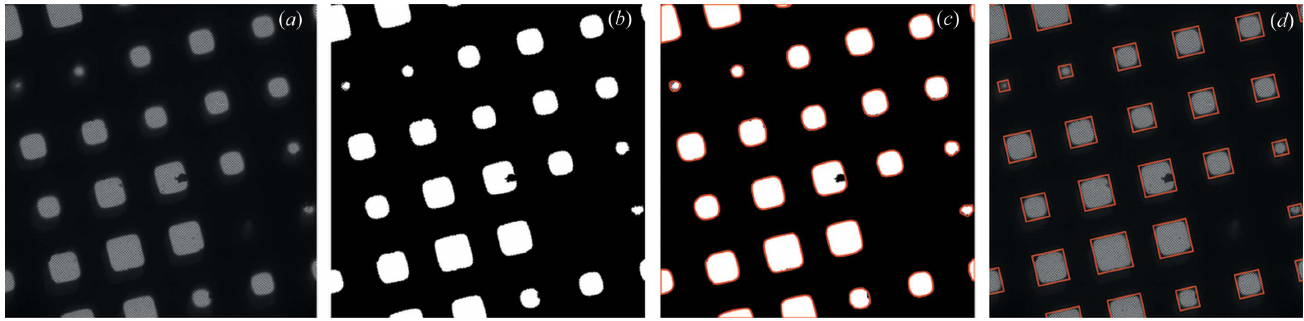
Figure 4 Example of the square localization procedure. ( a ) Original input image. ( b ) Mask recovered after segmenting pixels. ( c ) Finding convex polygons around the separate regions in the mask. ( d ) Aligned minimum bounding rectangles around the polygons, used for crops of the